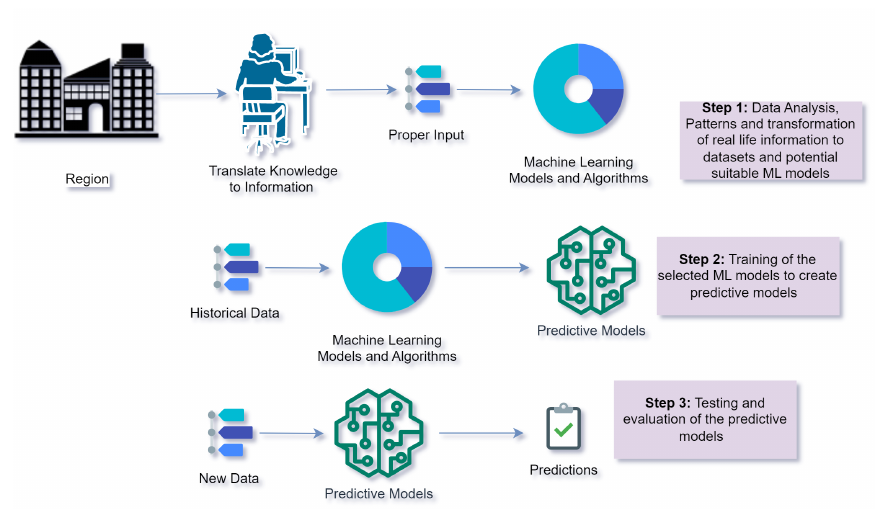
Figure 8: Methodology